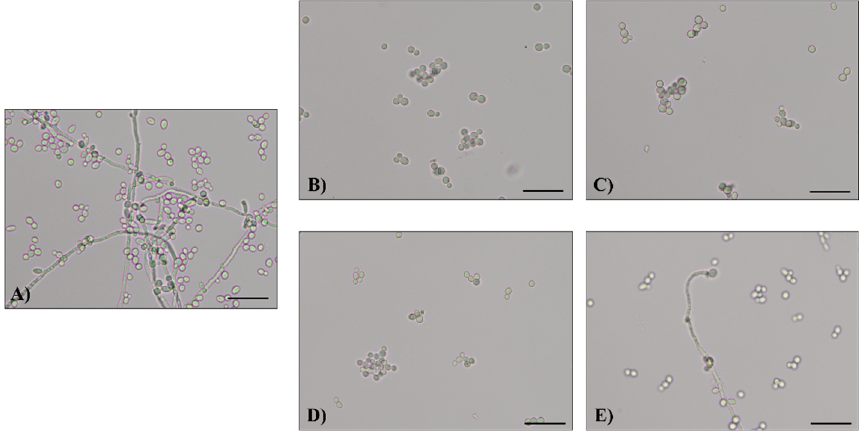
Figure 1. Representative images of C. albicans SO1 cell morphology obtained by optical microscope (20×): ( A ) growth control, ( B ) sample treated with pk-CFS from L. crispatus BC3, ( C ) sample treated with bf-CFS from L. crispatus BC3, ( D ) sample treated with pk-CFS from L. gasseri BC9, ( E ) sample treated with bf-CFS from L. gasseri BC9. Scale bar = 50 μ m. Table 1. Inhibition of Candida morphology switching by lactobacilli pk-CFS and bf-CFS. +, inhibition of germ tube, pseudohyphae, or hyphae formation, evaluated by microscopic observation of at least three microscopic fields; -, absence of inhibition (i.e., formation of germ tubes, pseudohyphae, or hyphae comparable to the corresponding control sample).